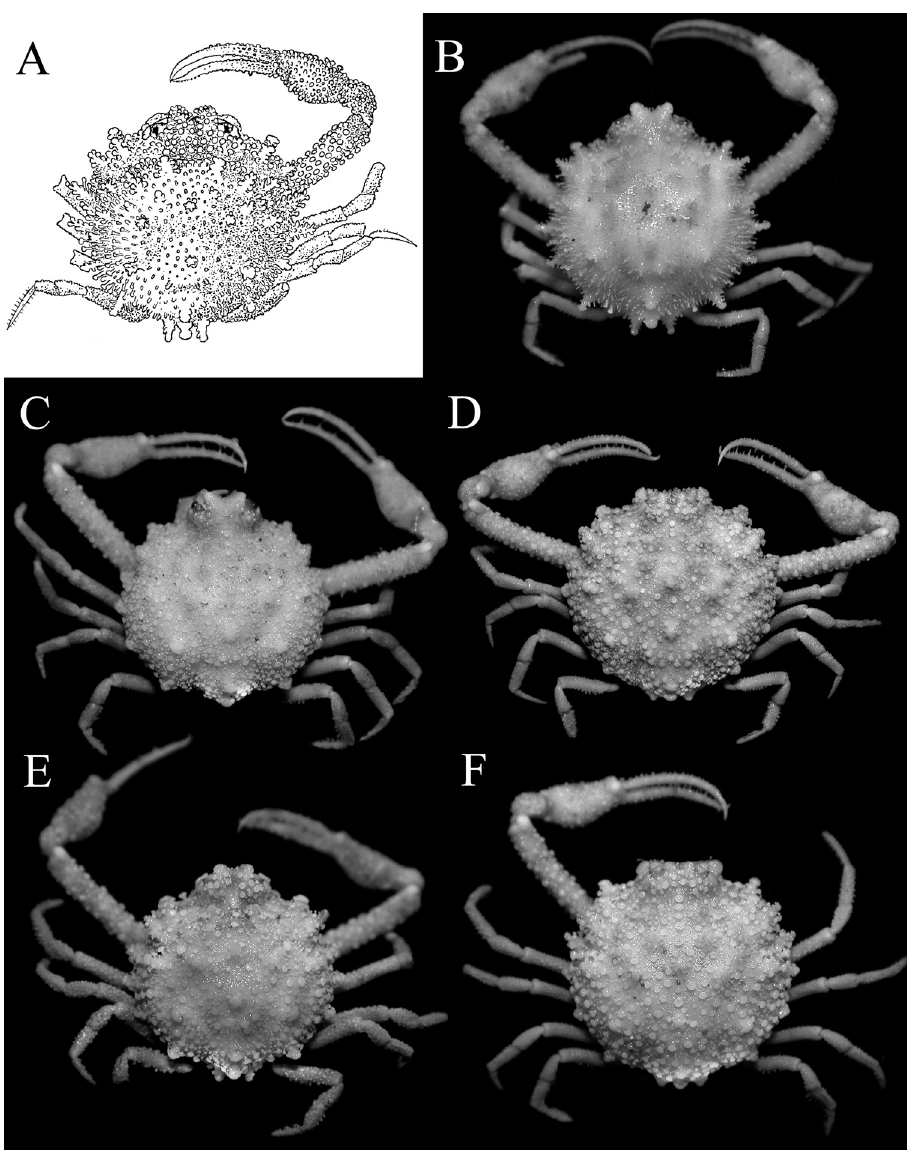
Figure 4. Pariphiculus agariciferus Ihle, 1918, overall dorsal view. A holotype male (9.0 × 9.3 mm), after Ihle (1918: fig. 230) B young male (10.2 × 9.6 mm) (ZRC 2009.470), Vanuatu C male (11.9 × 12.1 mm) (ZRC 2009.471), Vanuatu D female (22.1 × 21.3 mm) (ZRC 2009.288), Philippines E male (15.5 × 14.4 mm) (ZRC 2012.484), Philippines F female (19.0 × 19.0 mm) (ZRC 2017.186), Philippines. Island, 120–160 m, coll. J. Arbasto, January–December 2007 [all above locations at 9.518891°N, 123.680511°E, Panglao, Bohol, Visayas, Philippines; purchased from lo- cal shell fishermen, obtained by tangle nets]; 1 male (17.2 × 16.9 mm), 2 females